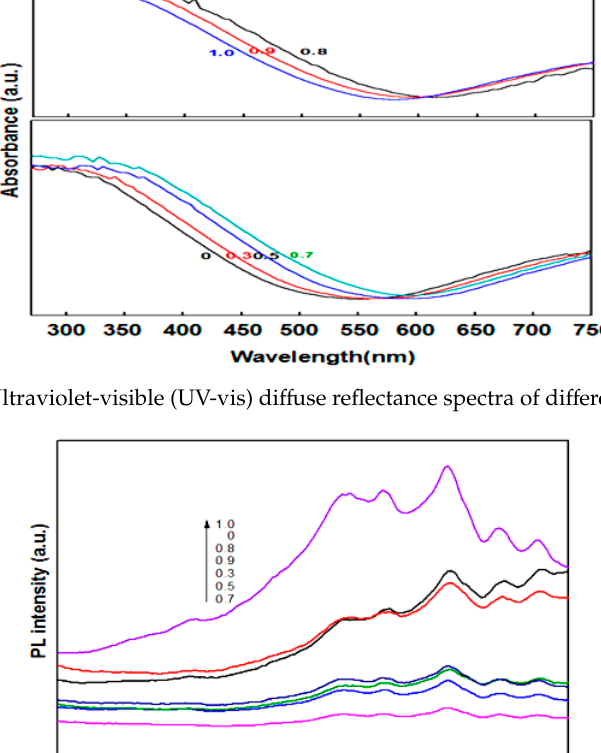
Table 2. Photocatalytic activity of different nanoparticle s.